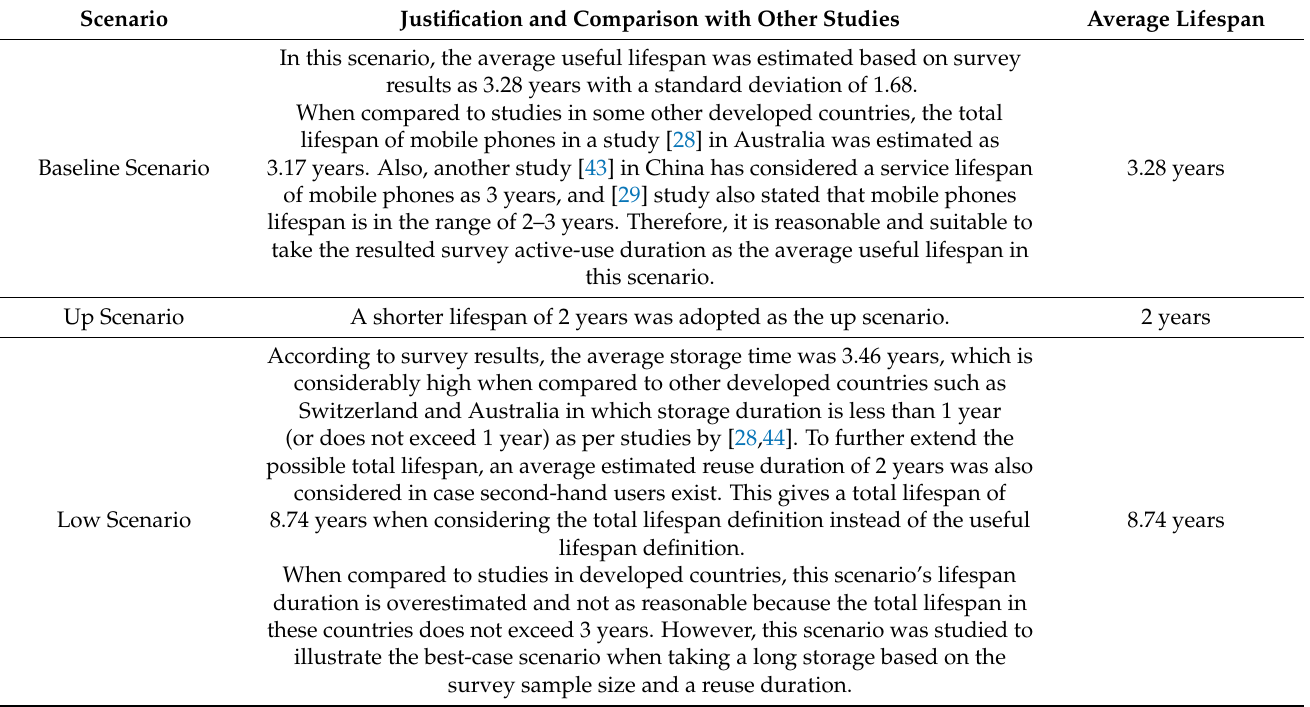
Table 8. Lifespan scenarios.